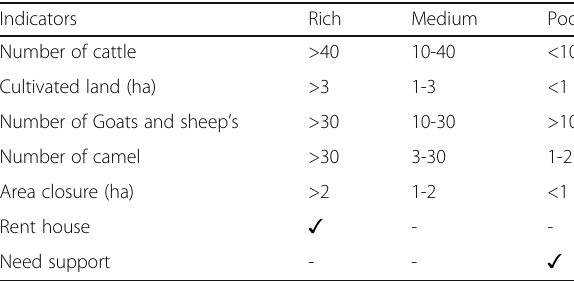
Table 1 Wealth indicators of the agro-pastoralist community